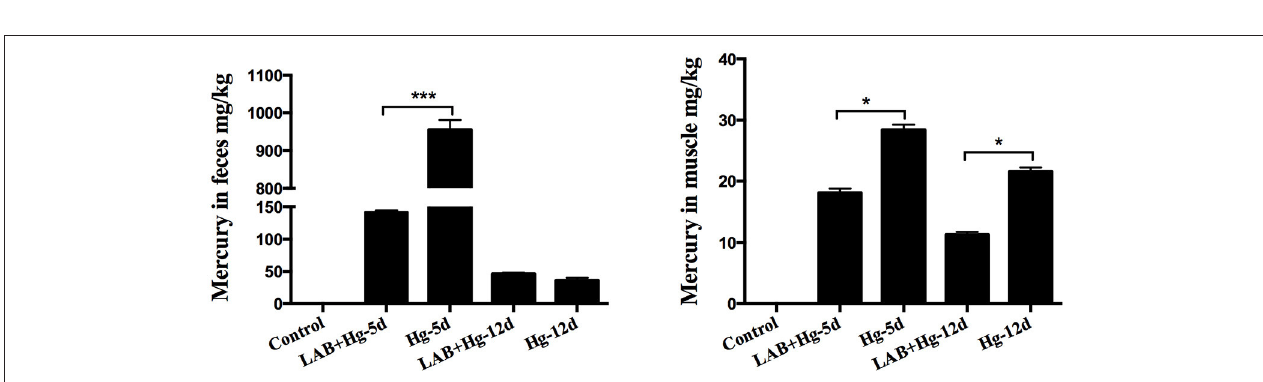
FIGURE 3 | Analysis of Hg concentrations in tissue samples revealed dose-dependent increases in Hg levels. Hg was not found in the fecal samples of controls. Concentrations are expressed as mg of Hg per kg of feces and muscle. Asterisks indicate significant differences ( p < 0.05). Results are represented as the mean ± SEM of three independent